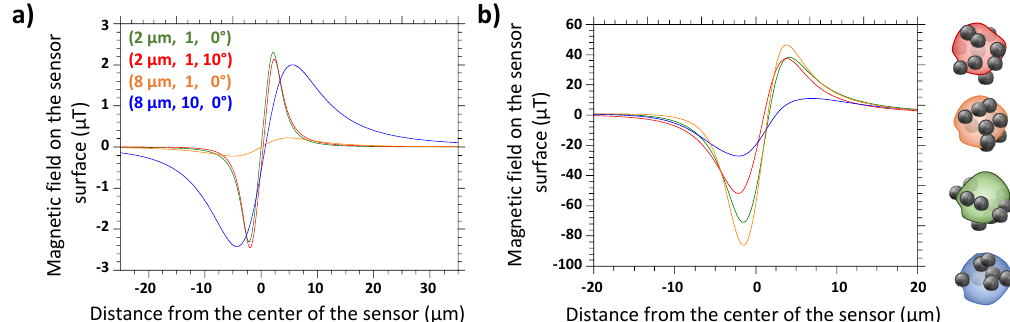
Figure 4. ( a ) Simulation results of the magnetic object detection demonstrating the influence of the three main parameters: distance between object and sensor (Z), number of magnetic particles (MPs) (N) and moment orientation ( θ ). Curves are labeled by the triplet (Z,N, θ ). ( b ) Simulation results for a 6 µ m diameter cell at 6 µ m height covered by 10 MPs, with four sets of random positions of the beads on the cell